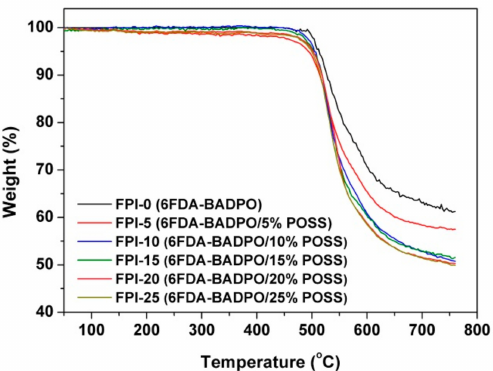
Figure 7. Thermogravimetric analysis (TGA) curves FPI / TSP films at a heating rate of 20 ◦ C / min under nitrogen